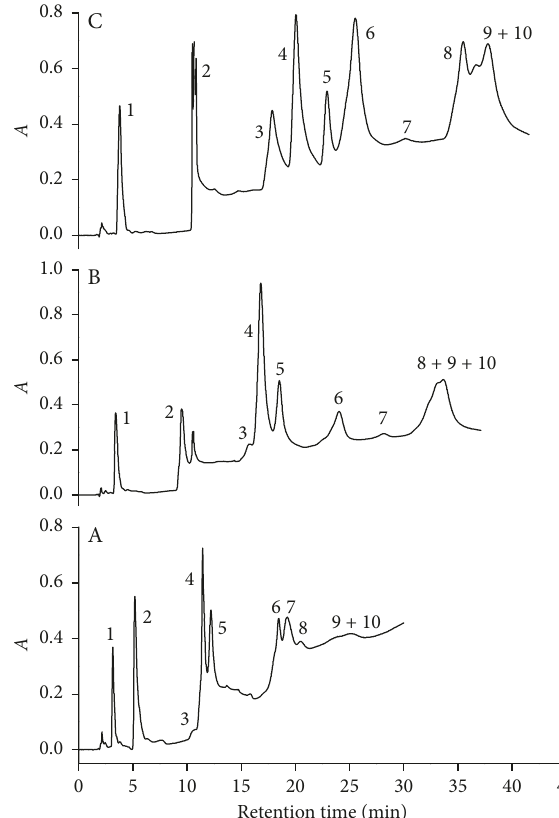
Figure 1: Influence of the nature of the organic modifier in the analyte separation. Solvents: (a) n -butanol, (b) n -propanol, and (c) ethanol. Data were obtained for standard solution of amoxicillin (1), caffeine (2), tetracycline (3), diclofenac (4), ibuprofen (5), 17 α - ethynylestradiol (6), levonorgestrel (7), nimesulide (8), ciprofloxacin 1 , with (9), and norfloxacin (10) in the concentration of 20.0mg L · 1 , at 25 ° C, and a injected volume of 20 μ L, at a flow rate of 1.0mL min − · detection at 220nm. Phase A with 3.0% (v/v) of solvent and 0.3% − (m/v) SDS and phase B with 15% (v/v) of solvent and 3.0% (m/v) SDS 1 of phosphate at pH 7.0. The mobile phase and both with 20mmol L · was changed from 100% of phase A to 100% of phase B in 30min. A in − the y -axis is the